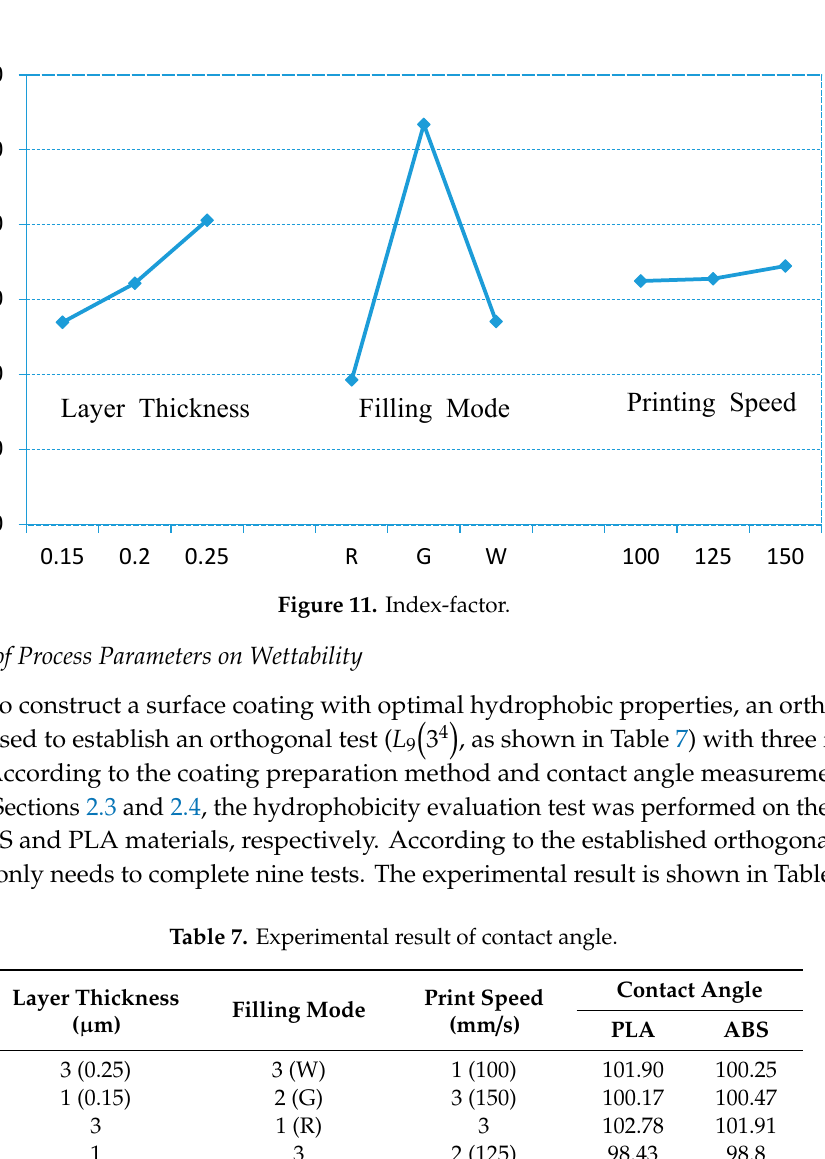
Table 8. Range analysis of contact angle measurement.